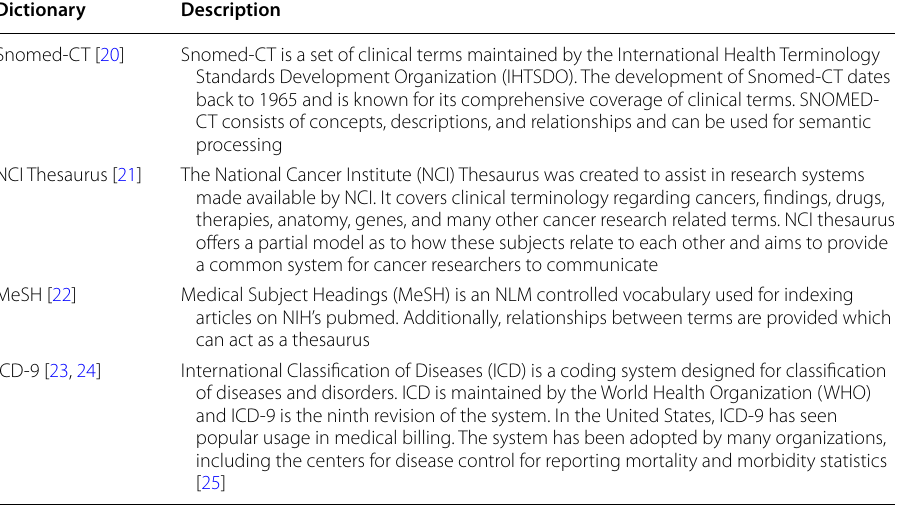
Table 1 Summary of dictionaries used by